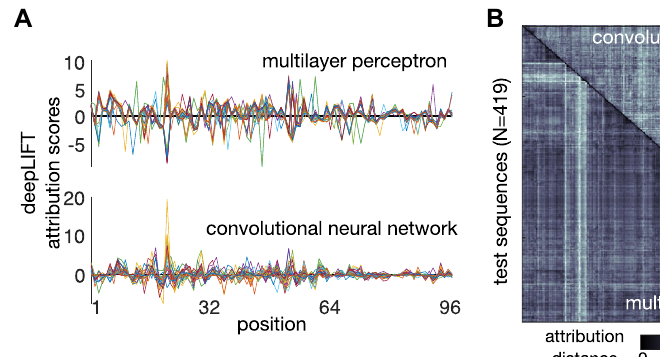
Fig. 4 | Sensitivity to input sequences using Explainable AI. A DeepLIFT 37 attribution scores per nucleotide position for a given test sequence and trained model. Panels show scores of 30 sequences chosen at random from the same test set employed in Fig. 3C for models trained on 75% of mutational series 21. B Attribution distances for models trained on series 21. We computed the cosine distance between DeepLIFT scores for each sequence in the test set.